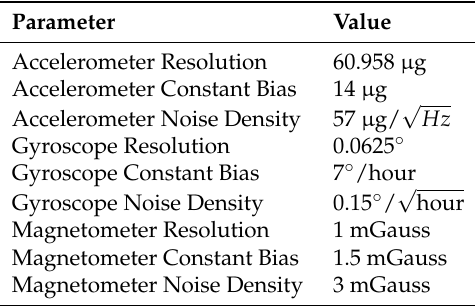
Table 1. Ellipse two micro IMU